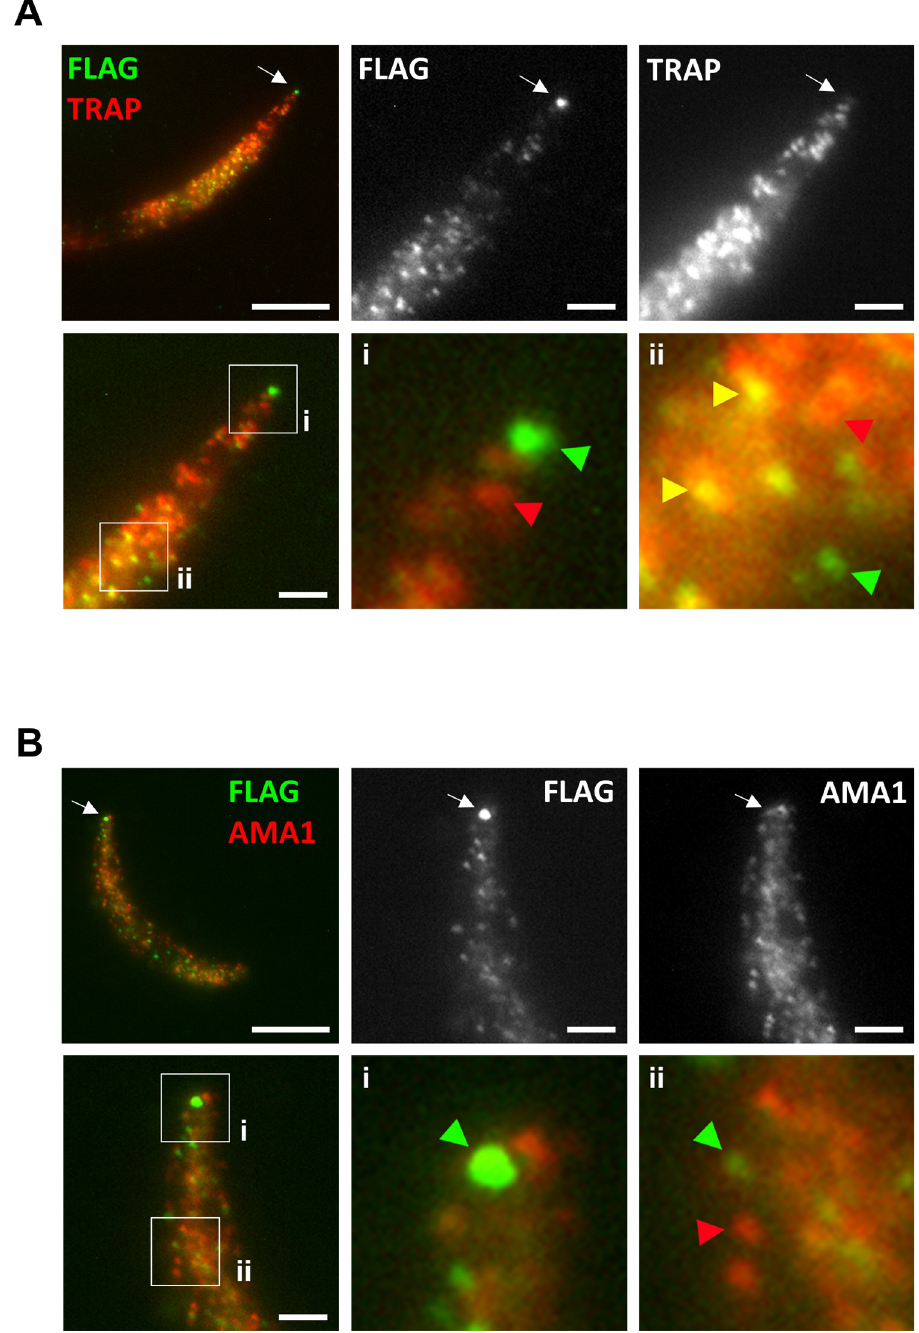
Fig 6. Expansion microscopy reveals a unique distribution of CLAMP in sporozoites. A. Salivary gland sporozoites expressing Flag-tagged CLAMP (untreated clamp cKO parasites) were examined by expansion microscopy using antibodies against Flag (green) and TRAP (red). Specific accumulation of CLAMP is clearly visible at the apical tip of sporozoites, as indicated by arrows in the upper panels. The lower i and ii magnified panels illustrate the distinct distribution of CLAMP (green arrowheads) and TRAP (red arrowheads), and the colocalization of both proteins in a subset of micronemes (yellow arrowheads). Scale bars, 10 μ m (upper left panel) or 2.5 μ m (other panels). B. Sporozoites labeled with antibodies against Flag (green) and AMA1 (red) were examined by expansion microscopy. Apical accumulation of CLAMP is indicated by arrows in the upper panels. The lower i and ii magnified panels illustrate the distinct distribution of CLAMP (green arrowheads) and AMA1 (red arrowhead). Scale bars, 10 μ m (upper left panel) or 2.5 μ m (other